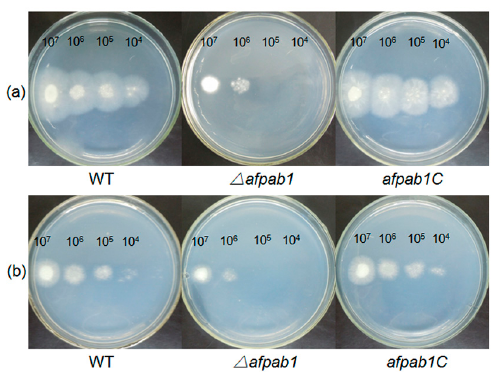
Figure 3. Plates assay. The A. fumigatus WT, Δ afpab1 and afpab1C strains were dot inoculated onto PDA at a gradient of 10-fold dilution for 36–48 h at 28 °C. ( a ) Medium containing 1.5 mM H 2 O 2 ; ( b ) Medium containing 10 µM menadione.